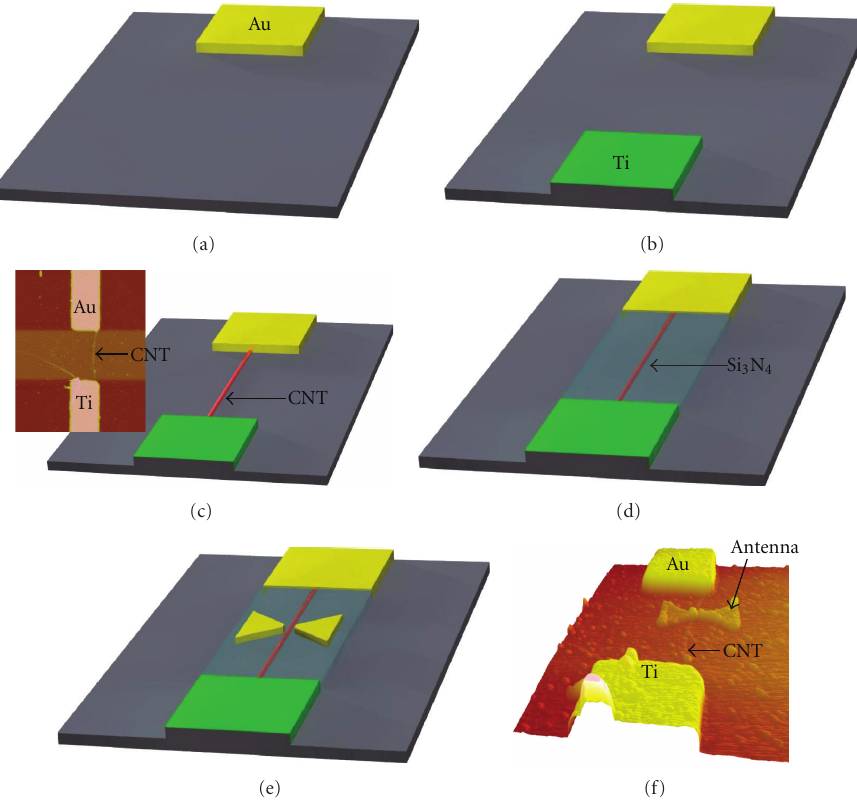
Figure 5: (a–e) Fabrication process of integrating a bowtie antenna to a CNT photodetector. The inset of (c) is an AFM image of an SWCNT bridging a Ti and an Au electrode. (f) A 3D AFM image of the device.